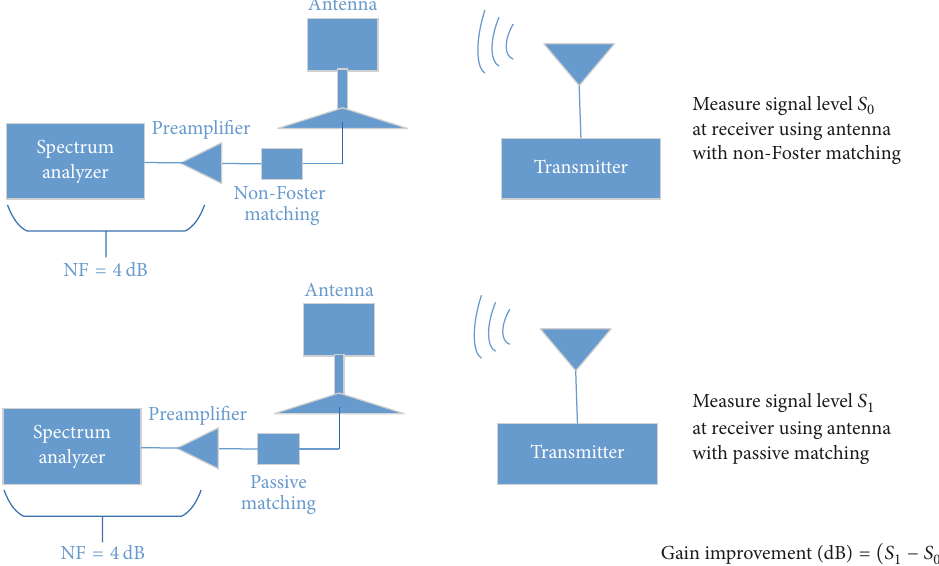
Figure 12: Received SNR of a non-Foster matched antenna compared to that of a passive antenna attached to an amplifier.